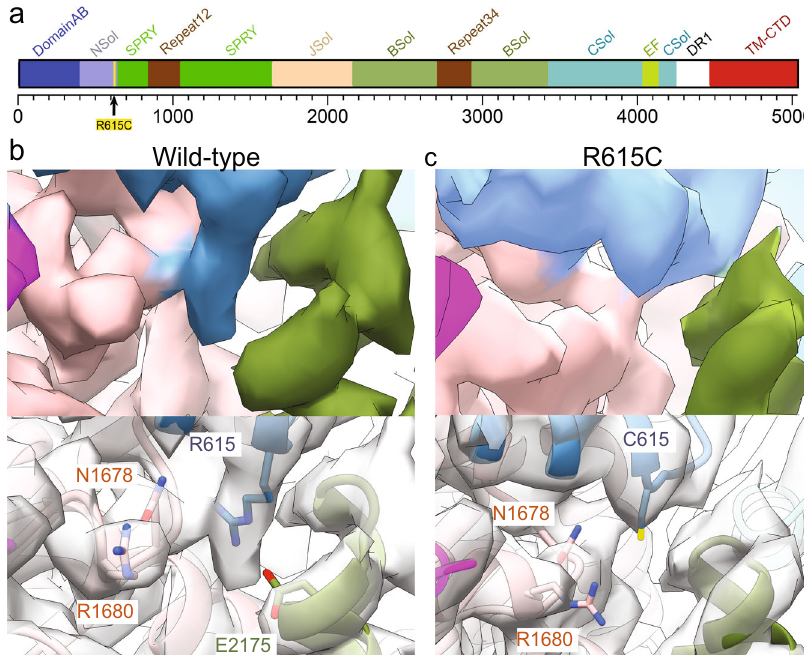
Fig. 2 Arg615 mediates interactions between the Nsol, Bsol, and Jsol regions. a Schematic view of various structural elements in RyR1, using color coding used through the manuscript. The numbers below represent the amino acid residue numbering. The relative position of R615 is indicated. Nsol, N-terminal solenoid; SPRY, cluster of three SPRY domains; Jsol, Junctional solenoid; Bsol, Bridging solenoid; Csol, Central Solenoid; EF, EF-hand domain; DR1, Divergent region 1; TM-CTD, transmembrane region and C-terminal domain. b Map for WT pRyR1 (closed) highlighting the Arg615 sidechain. The Cryo-EM density is colored according to the scheme in panel ( a ). c Cryo-EM density of R615C pRyR1, showing a detail around residue 615. The WT map was resampled on the grid of the R615C pRyR1 map to allow for an unambiguous comparison. Volumes displayed for both maps are comparable (~710,000 A 3 ) with a σ of 2.5. This shows clear loss of the Arg615 side-chain density in the